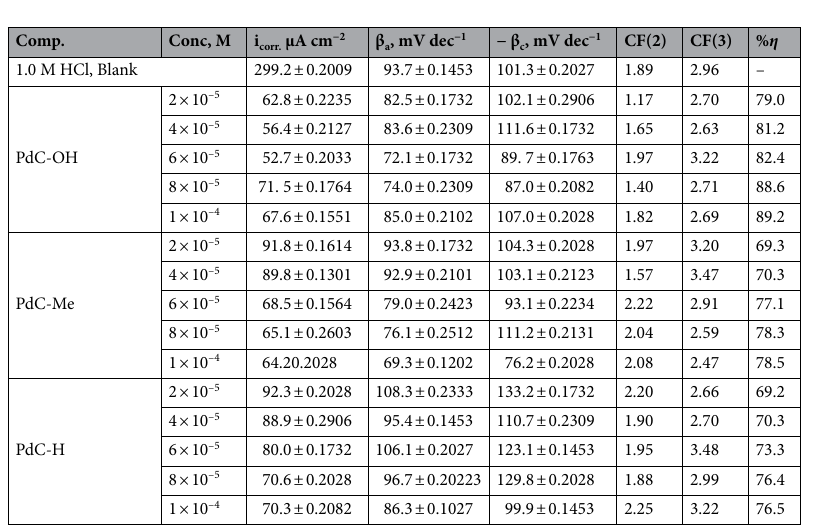
Table 9. Electrochemical parameters obtained from EFM technique for the corrosion of carbon steel in 1 M HCl at various concentrations of carbonitrile compounds at 25 °C.